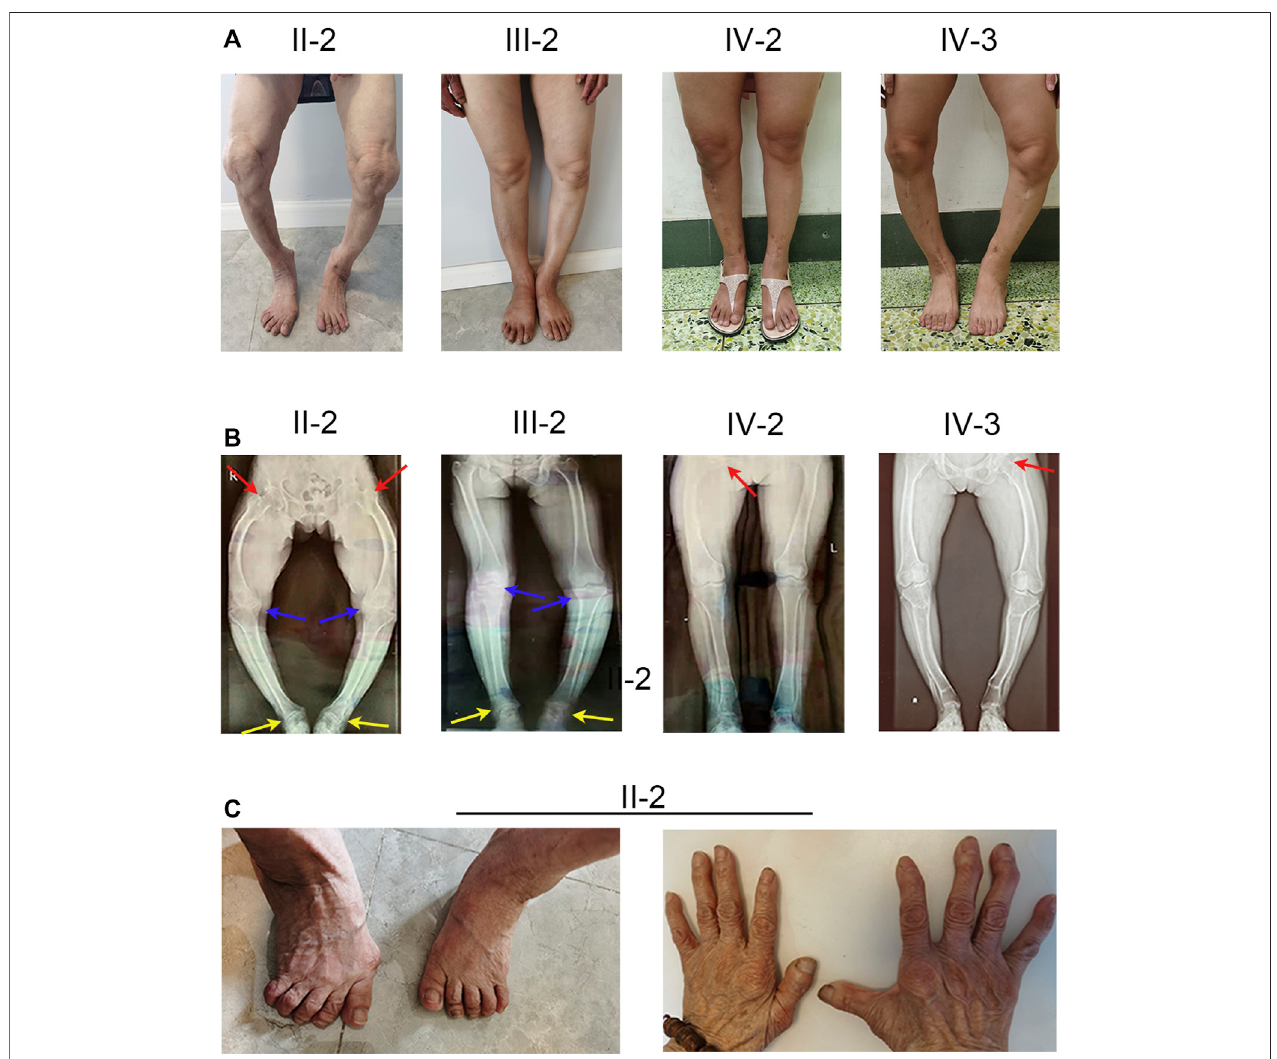
FIGURE 1 | Phenotype and X-ray autoradiographs of the family. (A) Clinical phenotype of the affected individuals in the family. The patients present with short statureandobviouslybowedlegs. (B) Theradiographsofthelowerlimbsofthepatientsshowvaryingdegreesofgenuvarumandosteoarthritis,withosteophytesonthe joint margins (indicated by arrows. hips, red; keens, blue; ankles, yellow). (C) Patient II-2 exhibits severe joint deformity of both hands and feet due to the lack of earlier